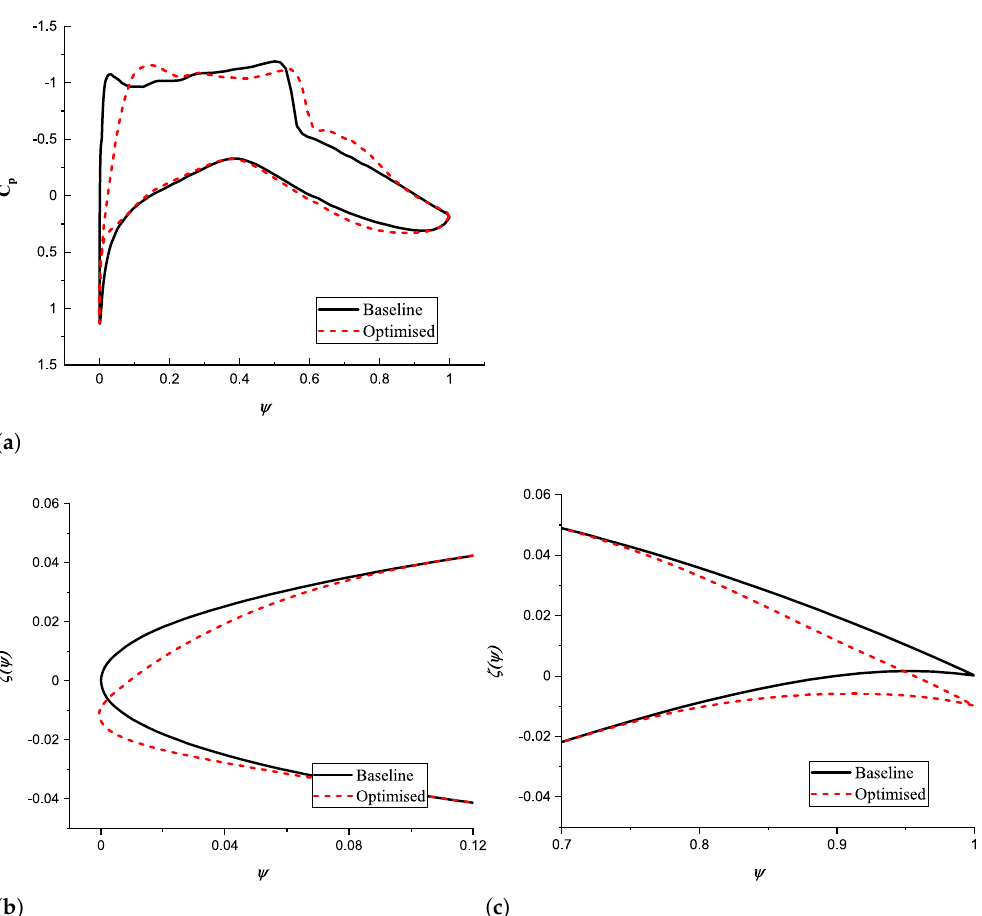
Figure 11. Comparison of results for the RAE 2822 optimization using morphing leading and trailing edges. ( a ) C p distribution. ( b ) Leading edge shape. ( c ) Trailing edge